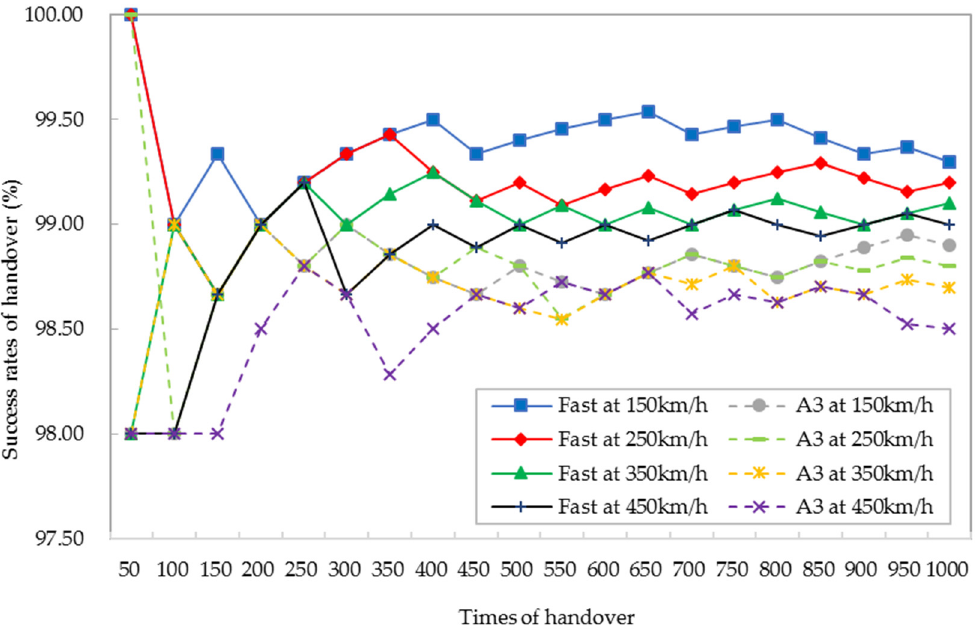
Figure 16. Comparison of the success rates of the handover between the fast handover algorithm and the A3 handover algorithm.